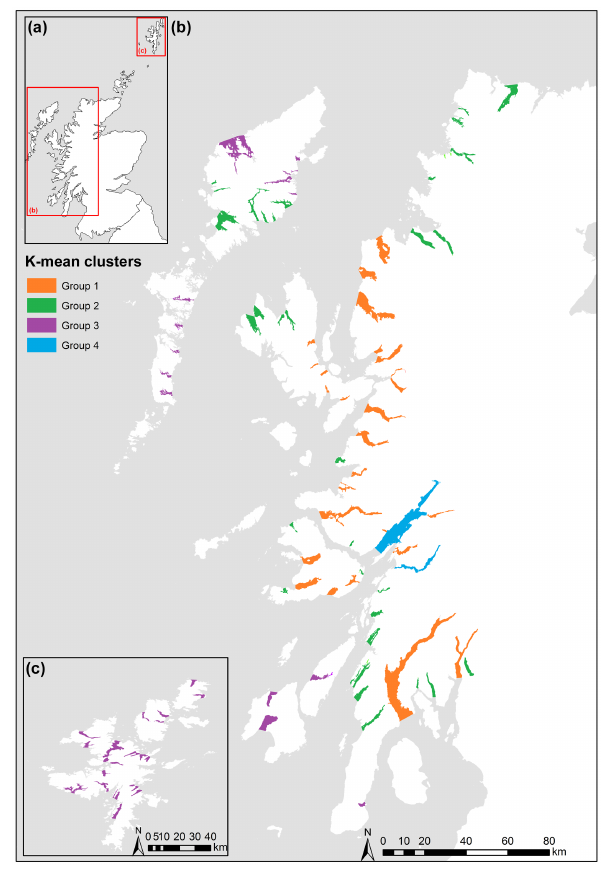
Figure 2. Output from the k-means analysis showing the spatial distribution of the four different groups of fjords.